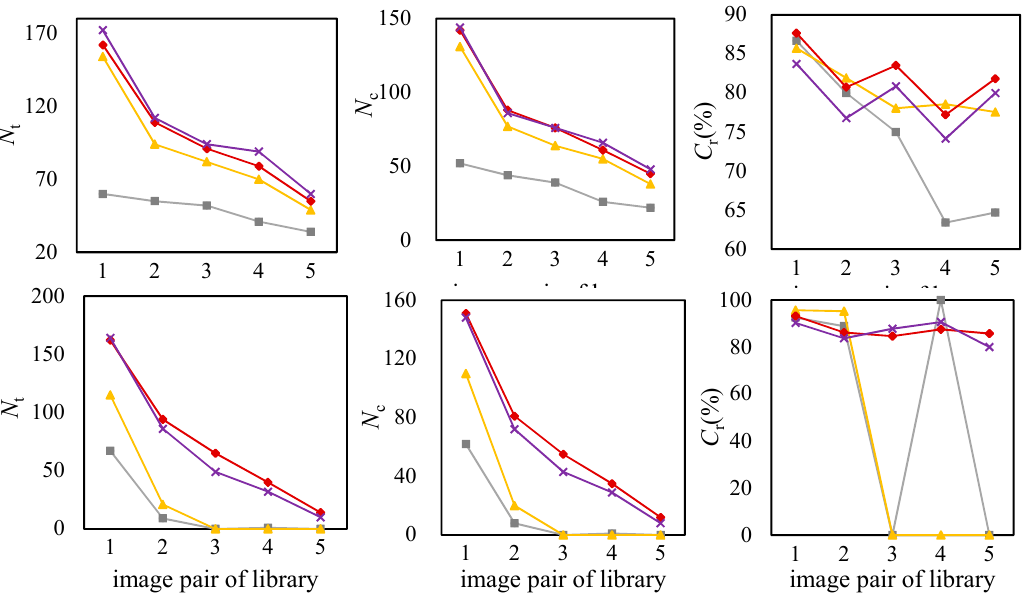
Figure 5. Results of different matching methods for the test data. N t : number of total matches; N c : the number of correct matches ; and C r : correct matching rate (%).